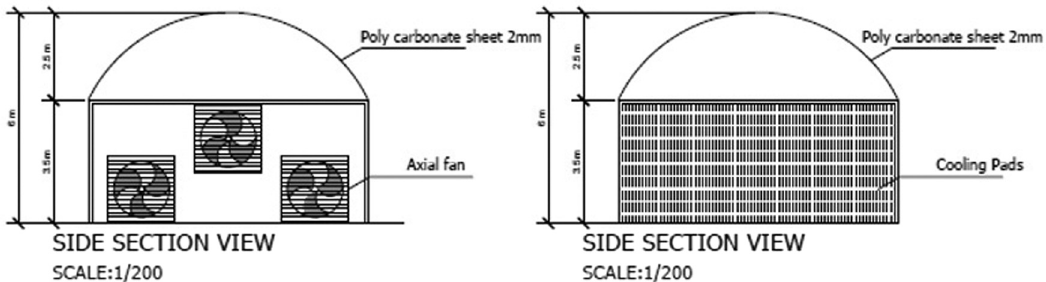
Figure 3: Sectional view of the conventional greenhouse